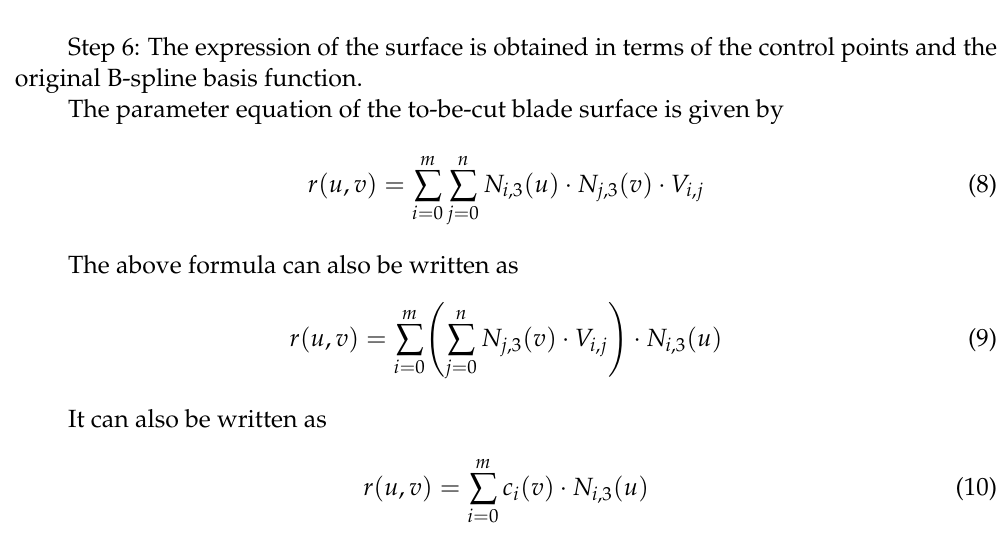
(cid:0) (cid:1) x i , j , y i , j , z i , j are the control points of the